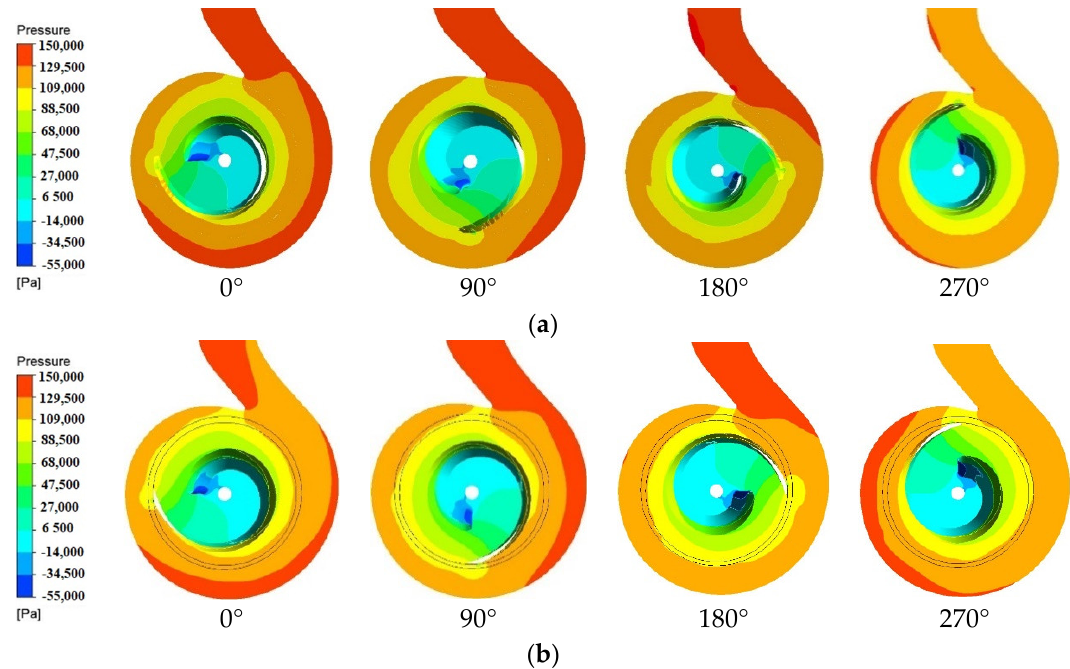
Figure 8. Pressure contours at different moments. ( a ) When the impeller has no eccentricity. ( b ) Model